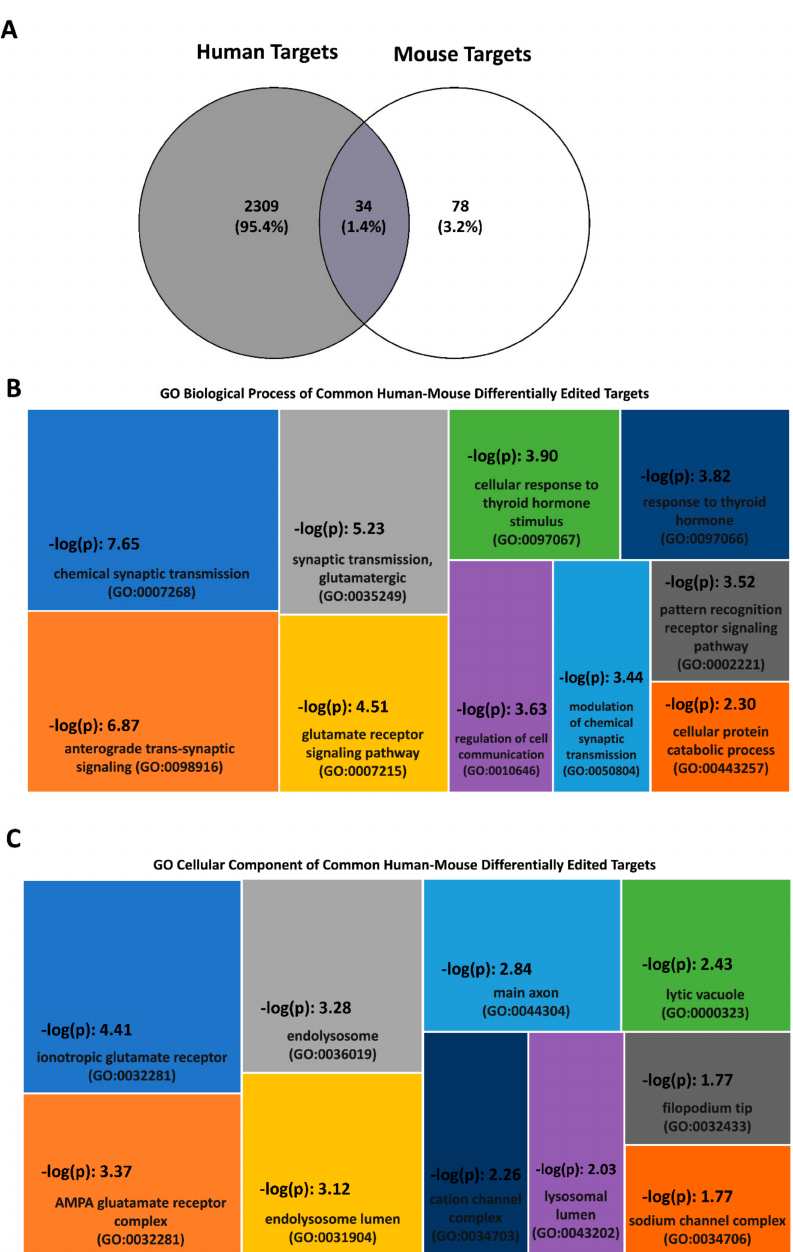
Figure 3. Differentially edited targets in human neuropsychiatric, autoimmune/neurodegenerative, neurological disorders [35,45,51] and in neurological/neurodegenerative disease mouse mod- els [31,43,57] compared to healthy controls. ( A ) Venn diagram depicting differentially edited tran- scripts identified in humans and mice compared to healthy controls. The intersection represents editing targets commonly identified as DE in human and mouse brain disorders. ( B , C ) Gene ontol- ogy (GO) analysis of the differentially edited targets in human and mouse brain disorders ( n = 34). Enrichment values are given as –log (p) values (higher –log ( p ) values indicate greater statistical significance). ( B ) Biological process enrichment. Common DE transcripts are involved in molecular processes associated with synaptic transmission and signaling, regulation of cell communication, pattern recognition receptor signaling, response to thyroid signaling and protein catabolism. ( C ) Cel- lular component enrichment. Main axon, glutamate receptor, cation and sodium channel complexes, lytic vacuoles and specifically endo/lysosome lumen, as well as filipodium tip, emerge as cellular component terms enriched in DE transcripts in both human and mouse brain